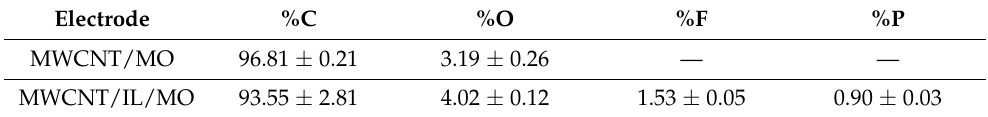
Table 1. Percentage values of weight for MWCNT/MO electrodes and MWCNT/IL/MO electrodes.